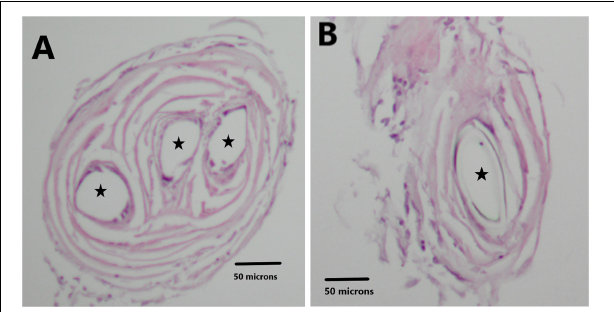
FIGURE 4 | Illustration of the electrode wires and tissue that was inside the glass cone. The numbers 1, 2, 3, and 4 indicate positions 1, 2, 3, and 4, respectively.